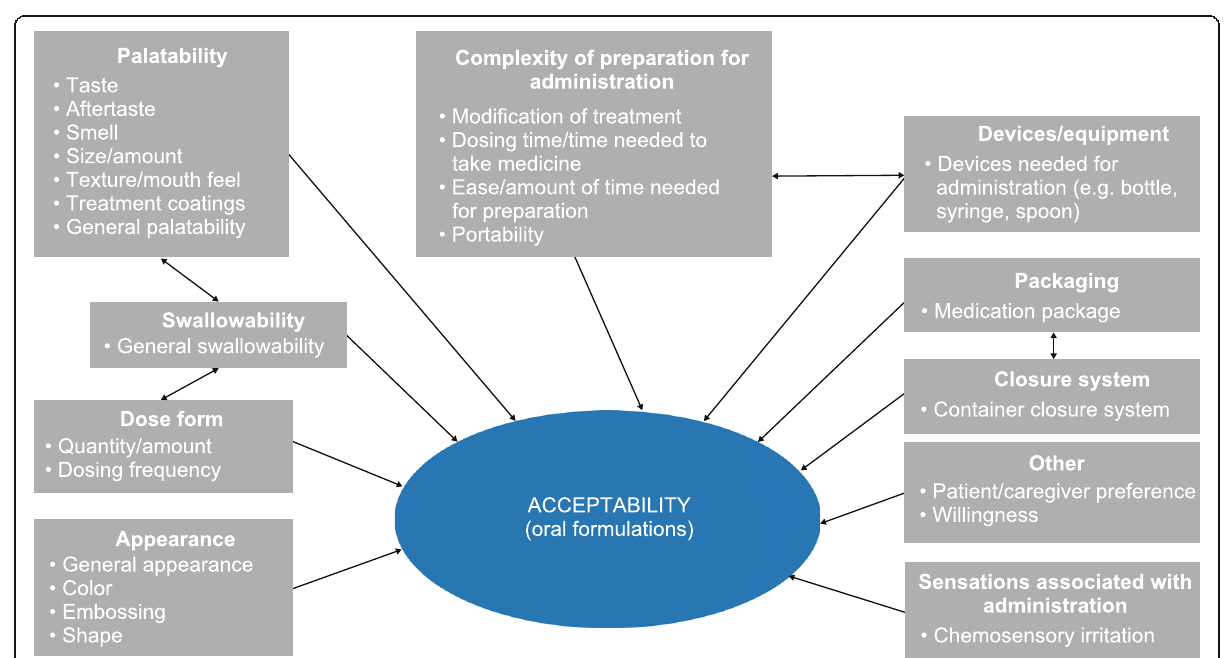
Fig. 1 Literature-based preliminary conceptual model of oral formulation acceptability attributes